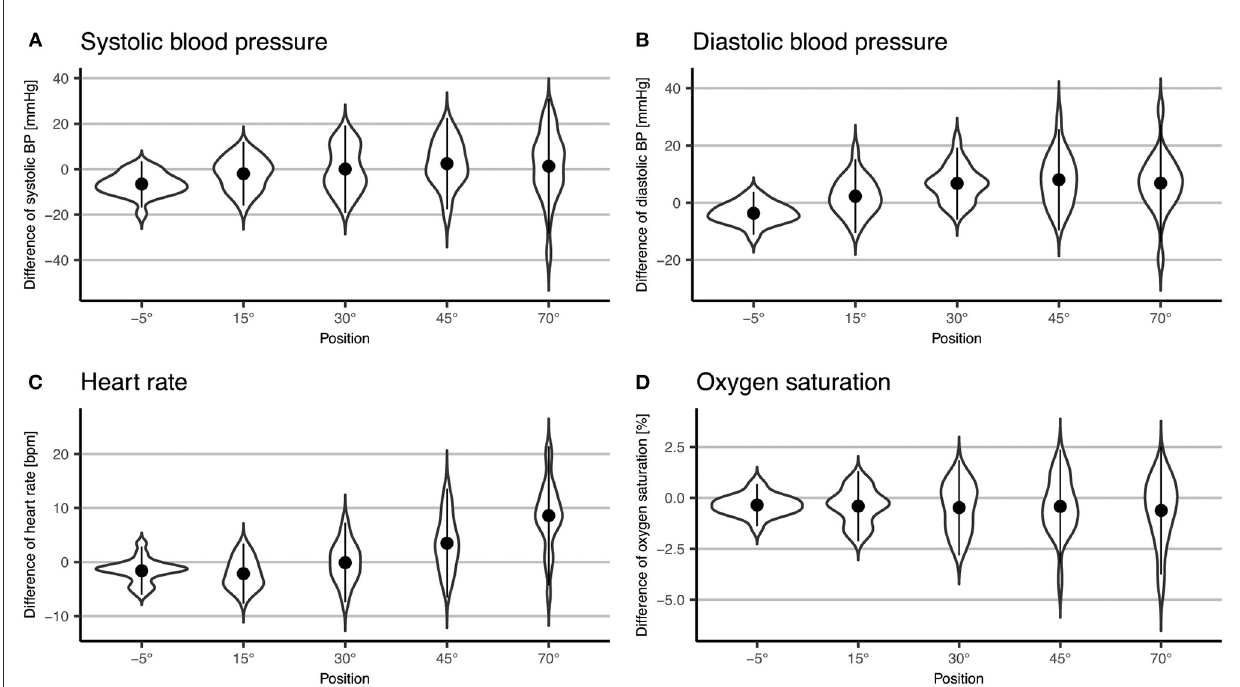
FIGURE4 Violin plot of difference to baseline of systolic BP (A) and diastolic (B) blood pressure, heart rate (C) and oxygen saturation (D) . Points represent means; error bars represent two standard deviations.